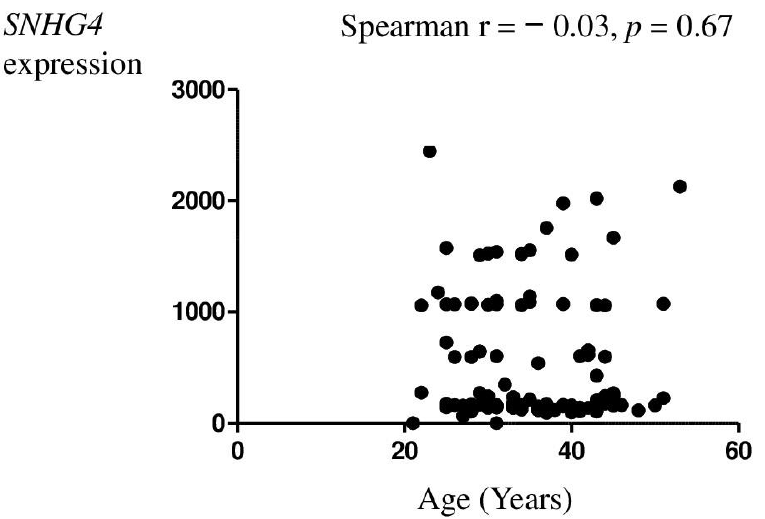
Figure 2. Relationship between patient age and relative expression of the SNHG4 gene.